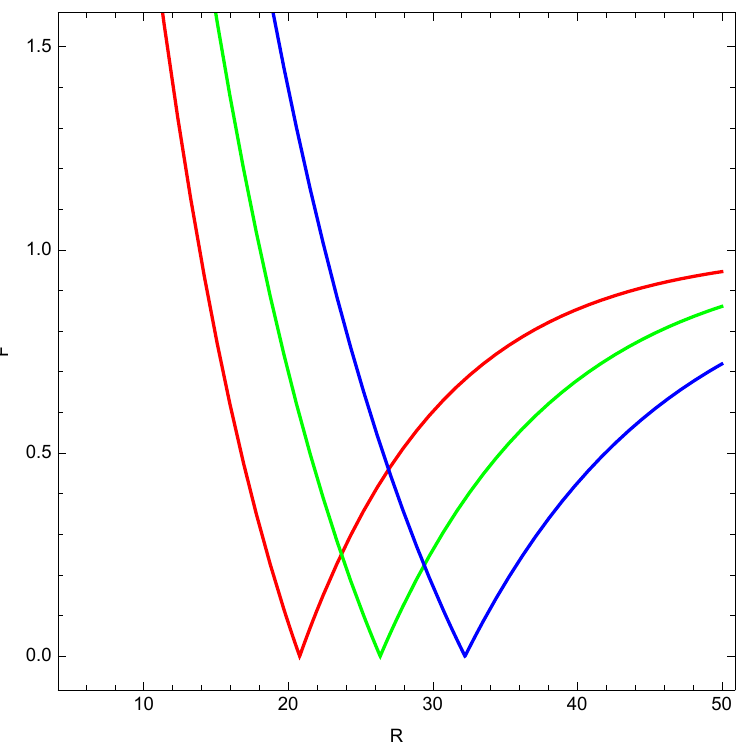
Figure 33. The evolution of F is obtained by Equations (33) and (49). The red, green, and blue lines correspond to small perturbations of R E and β , respectively.